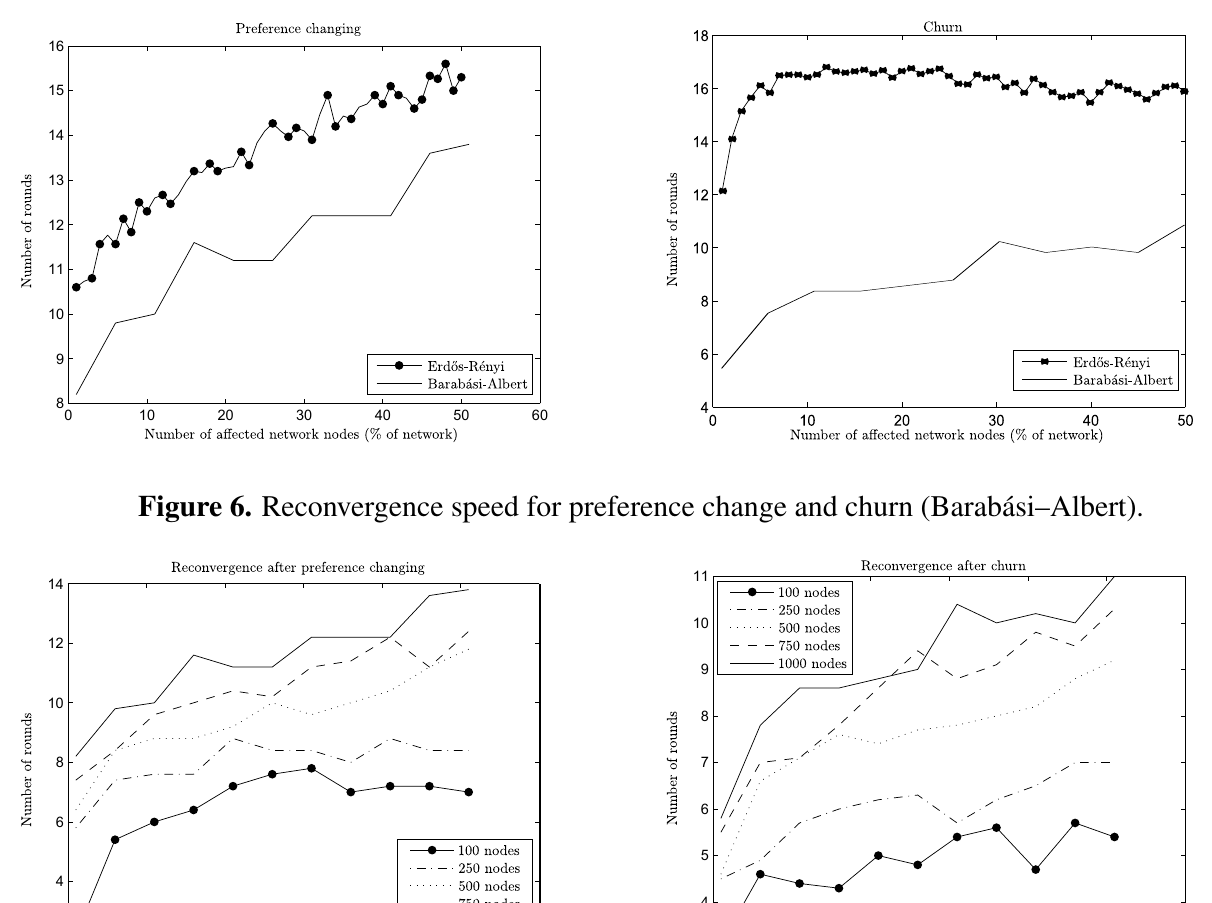
Figure 5. Reconvergence speed per operation, preference change/churn, n = 1 , 000 .